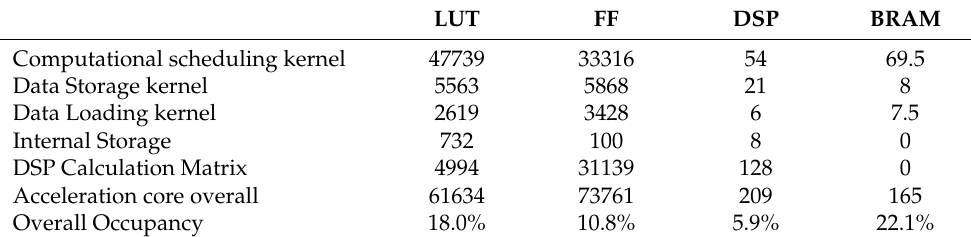
Table 3. Deep learning acceleration core overall resource